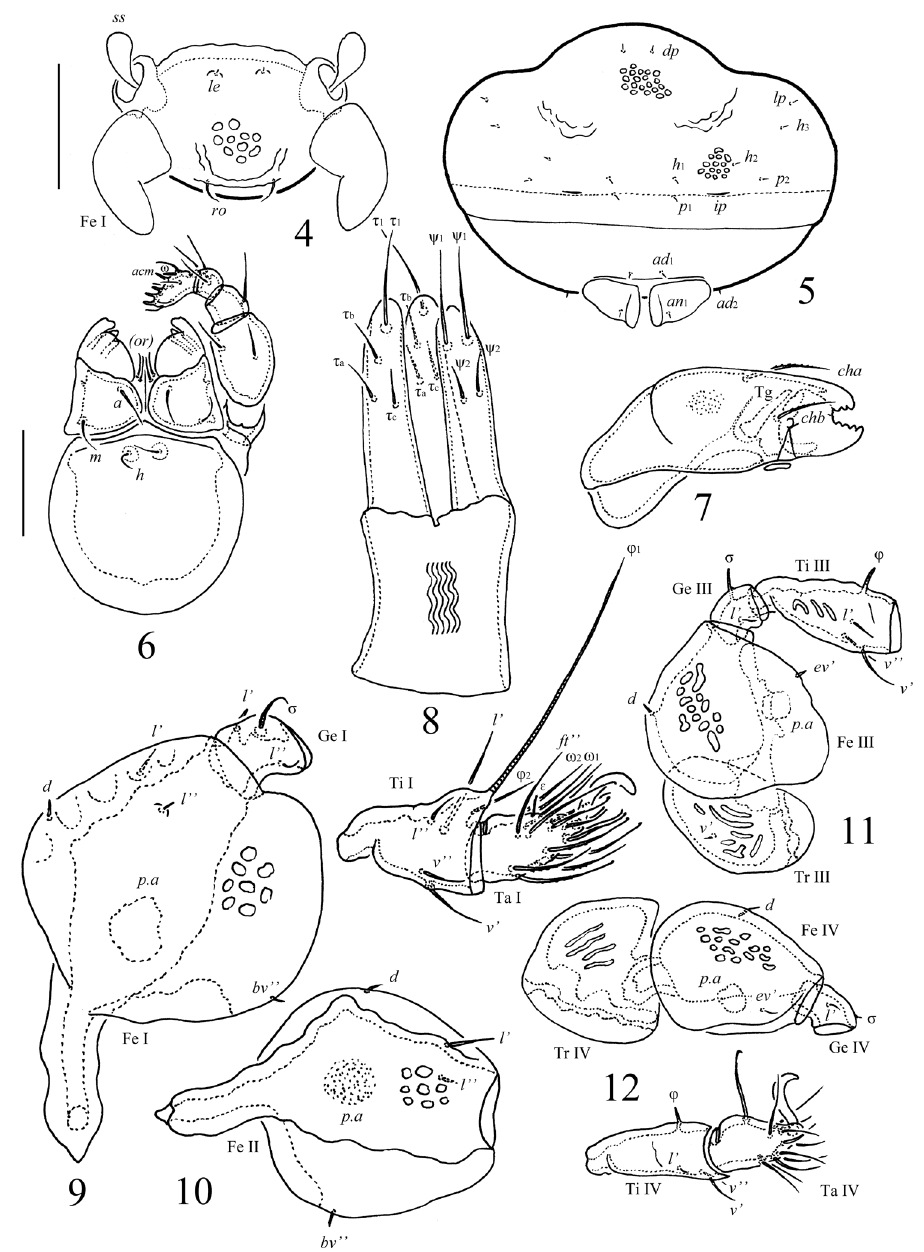
Figures 4–12. Scapheremaeus gibbus sp. n., adult: 4 frontal view of prodorsum (legs I except basal parts not shown) 5 posterior view 6 subcapitulum and palp 7 chelicera, antiaxial view 8 ovipositor 9 leg I, without trochanter, right, antiaxial view 10 femur of leg II, left, paraxial view 11 leg III, without tarsus, left, antiaxial view 12 leg IV, left, antiaxial view. Scale bars 50 µm ( 4, 5 ), 20 µm ( 6–12